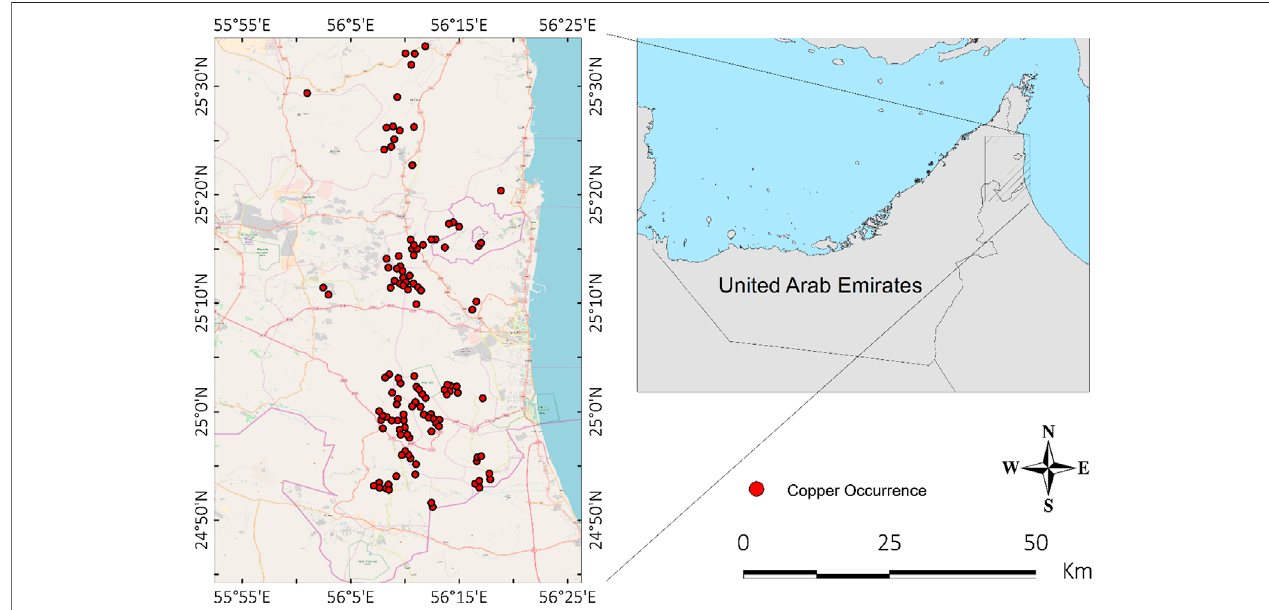
FIGURE19| Copper occurrencemapintheUnitedArabEmirates.Theultrama fi crocksareinshadesofpurple,layeredgabbrosinpalegreen,youngergabbrosin dark green, and higher-level gabbros in pale green and sheeted dykes in mid-green.